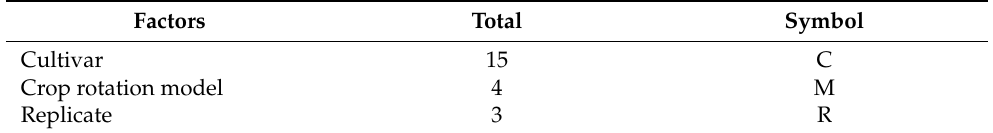
Table 1. Factors for the analysis of soybean cultivars and crop rotation models in rainfed agroforestry system by using linear mixed models. Factors Total Symbol Cultivar Crop rotation model